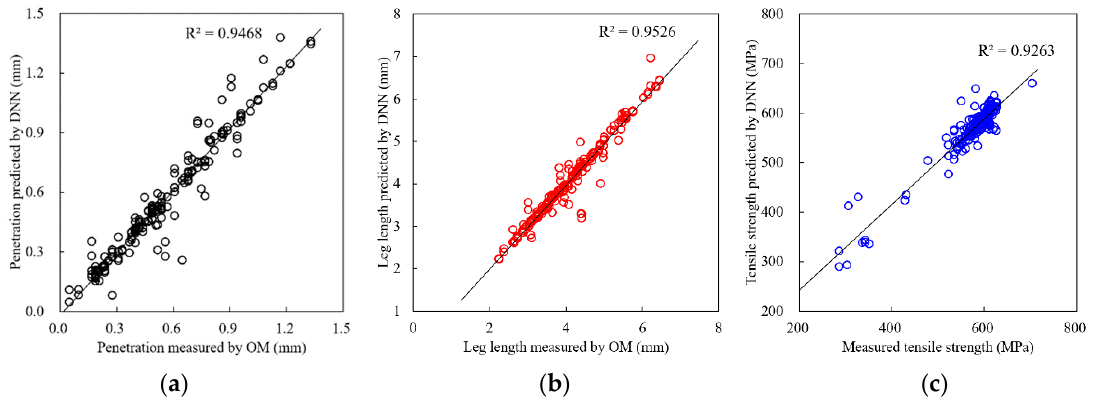
Figure 13. Verification of DNN prediction models for ( a ) penetration, ( b ) leg length, and ( c ) tensile strength.